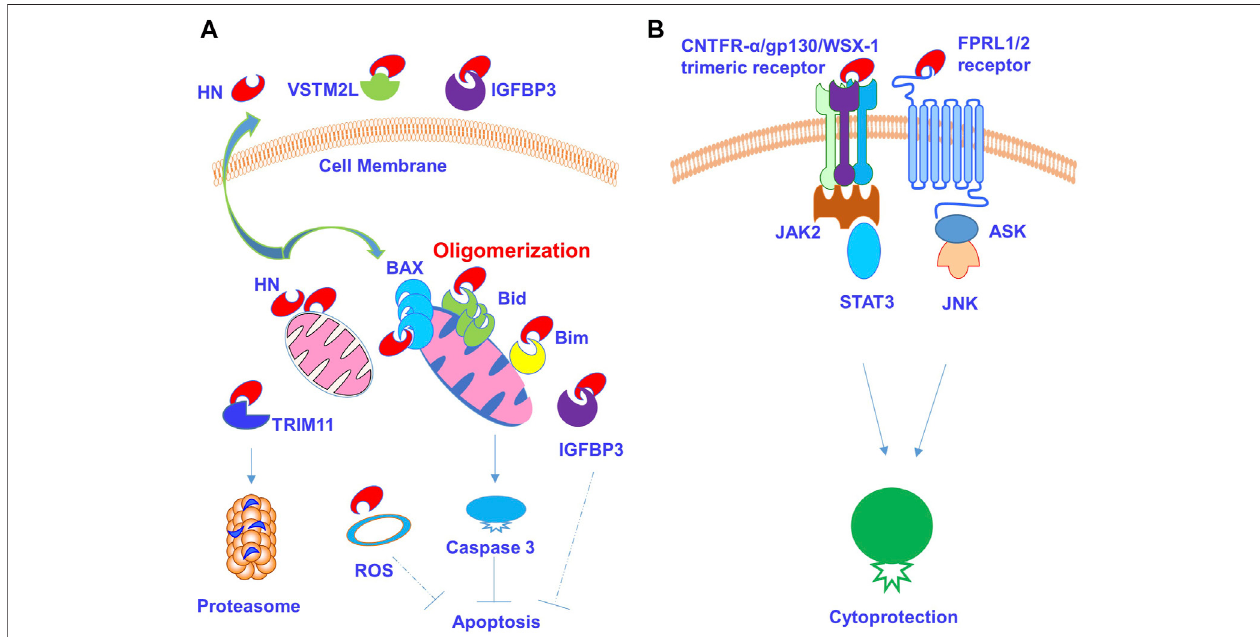
FIGURE 6 | HN and its receptors signalling pathways. (A) HN is present intracellularly and regulate apoptotic signalling pathways and cellular activity. HN binds Bcl2-associatedXprotein(BAX),BimandBidandcausestheiroligomerization.HNbindsintracellularIGFBP3tomediateapoptosis.HNalsodiminishesintracellularROS production. (B) Secreted HN binds cell surface receptors and mediatessignalling pathways and cytoprotectiveeffect.It also binds soluble extracellularproteins such as VSTM2L and